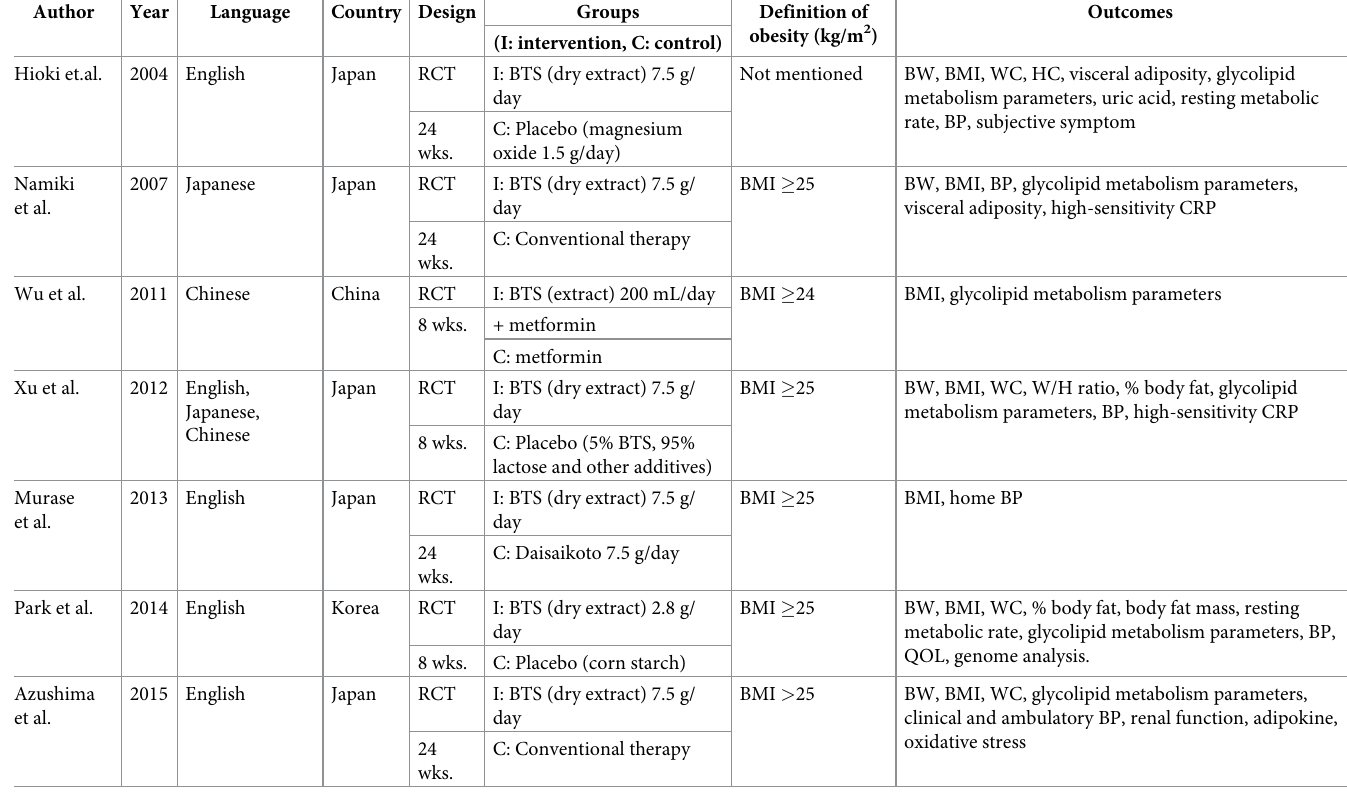
Table 1. Included